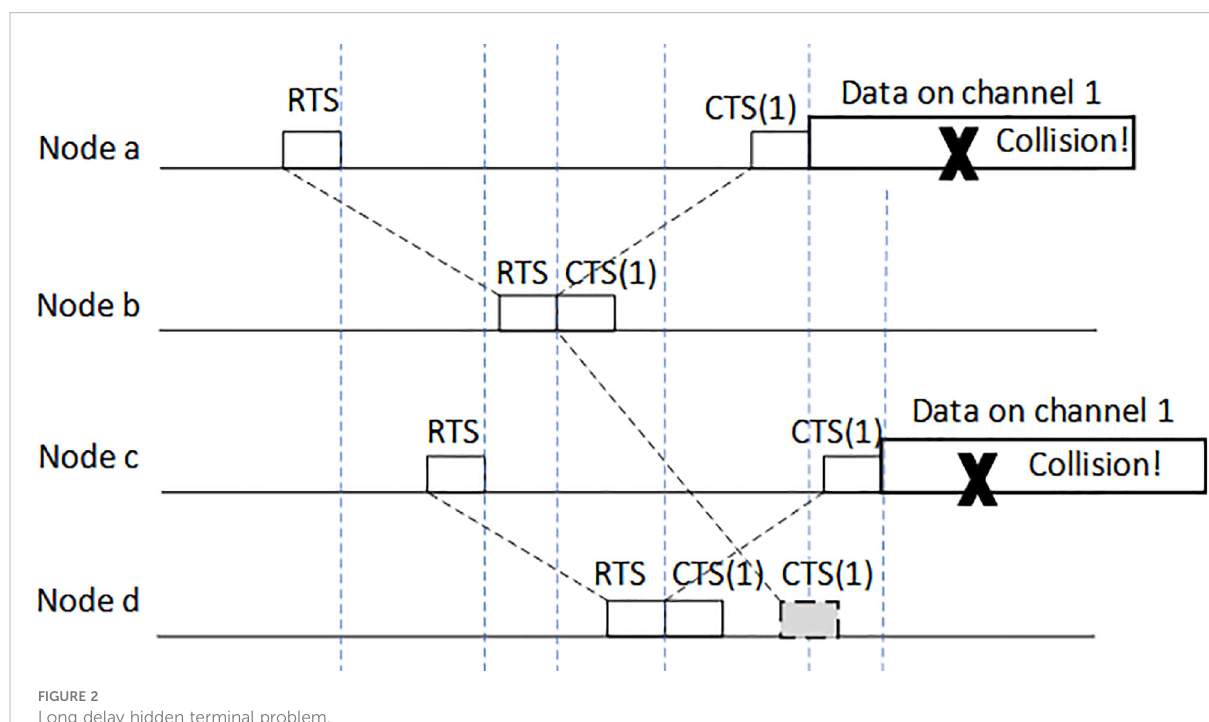
FIGURE 2 Long delay hidden terminal